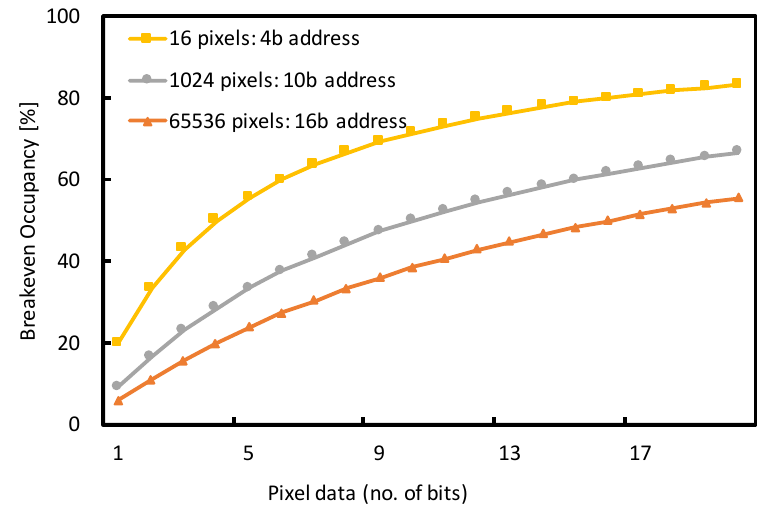
Figure 6. Break-even occupancy vs. number of pixel data bits per packet for pixel array sizes of 16, 1024 and 65,536 with 4, 10 and 16 address bits. When pixel occupancy is greater than the break-even occupancy, it is more efficient to read out all pixels rather than use zero suppression. The break-even occupancy of 50% is achieved when half of the data packet corresponds to the pixel address and the other half is pixel